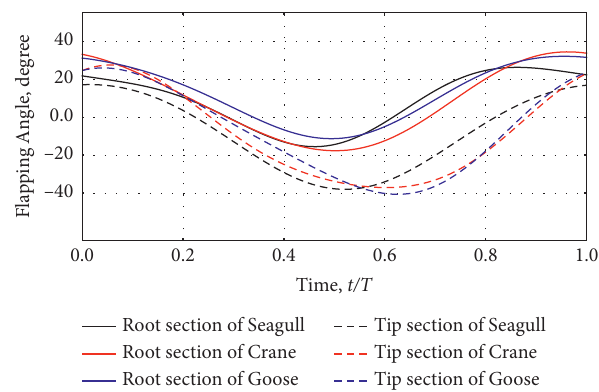
Figure 8: Rotations at the wing root and wing tip of seagull, crane, and